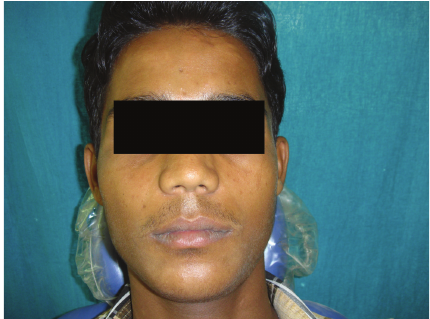
Figure 3: Maxillary cross-sectional occlusal radiograph showing radiolucency involving the right maxilla.